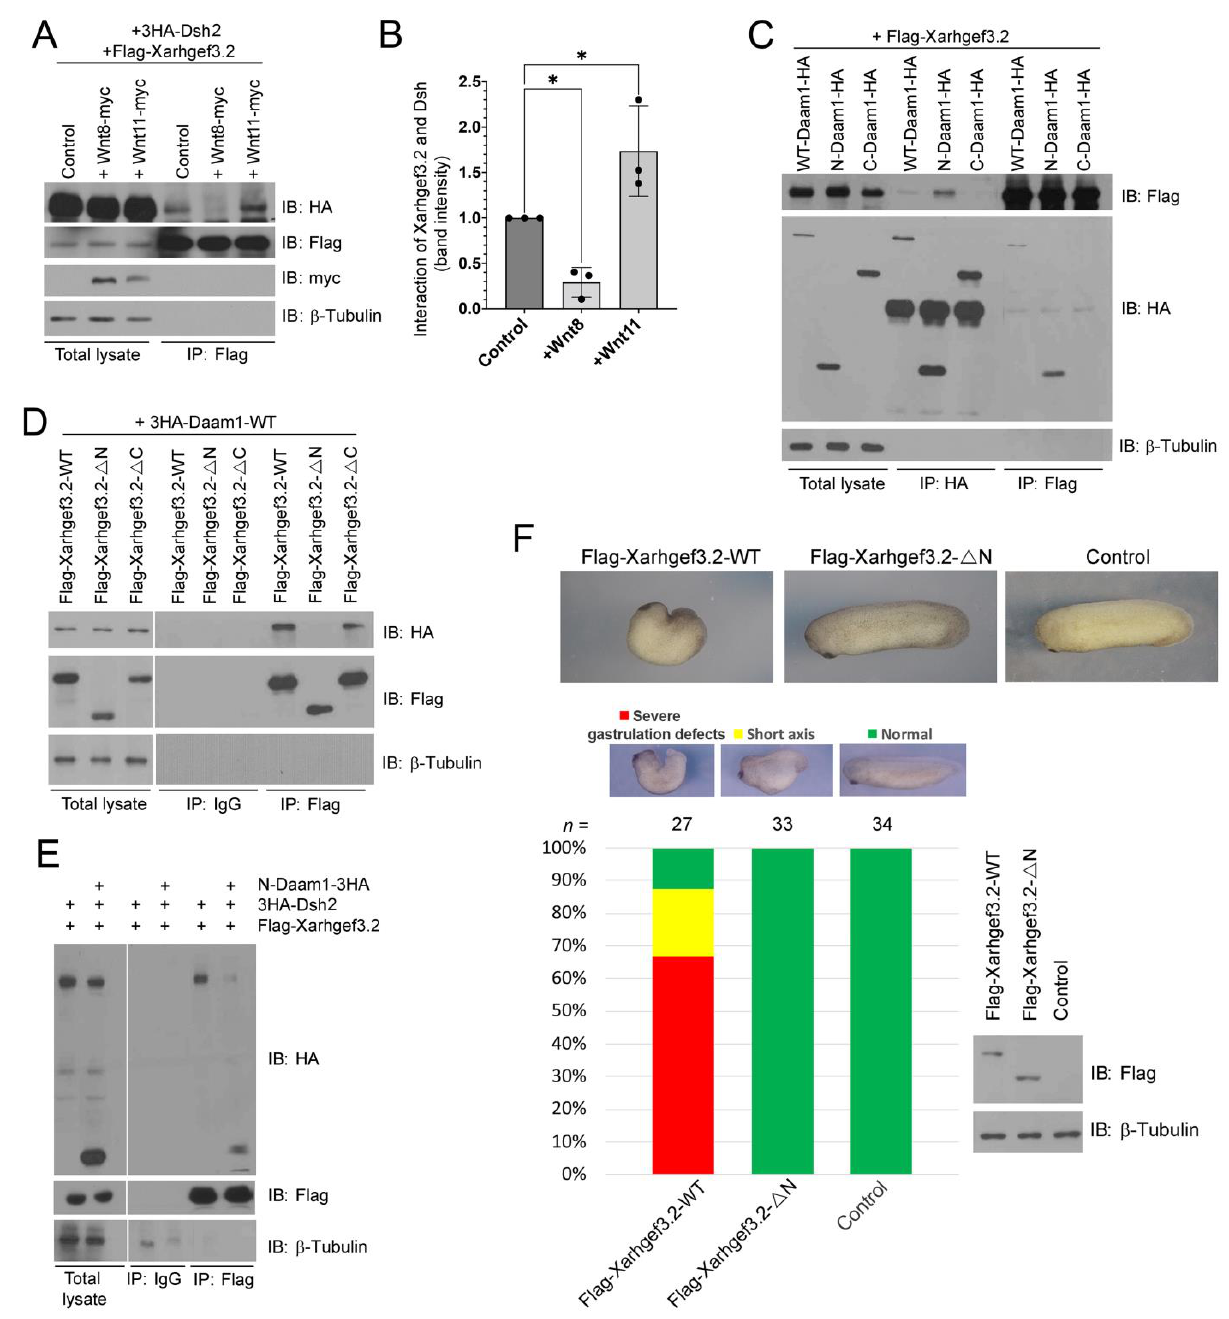
Figure 7. Xarhgef3.2 regulates gastrulation cell movements through interacting with noncanonical Wnt signaling components. ( A ) RNAs of Flag-Xarhgef3.2 (100 pg) and HA-Dsh2 (1 ng) were co-injected with wnt8-myc (500 pg) or wnt11-myc (500 pg) at the one-cell stage. Immunoprecipitation assay was performed with an anti-Flag antibody at stage 10. ( B ) The graph indicates the relative interaction level between Flag-Xarhgef3.2 and HA-Dsh2. Quantification with one-way ANOVA, scatterplots with bar represent the means ± SD from three biological repeats. Dunn’s multiple comparison, * p < 0.05. ( C ) RNAs of Flag-Xarhgef3.2 (100 pg) were co-injected with HA-WT-daam1 , HA-N-daam1 , or HA-c-daam1 (each, 1 ng) at the one-cell stage. Immunoprecipitation was performed with an anti-Flag antibody or an anti-HA antibody at stage 10. ( D ) RNAs of HA-WT-daam1 (1 ng) were co-injected with Flag-WT-Xarhgef3.2 , Flag- ρN -Xarhgef3.2 , or Flag- ρC -Xarhgef3.2 (each, 100 pg) at the one-cell stage. Immunoprecipitation assay was performed with an anti-HA antibody at stage 10. ( E ) RNAs